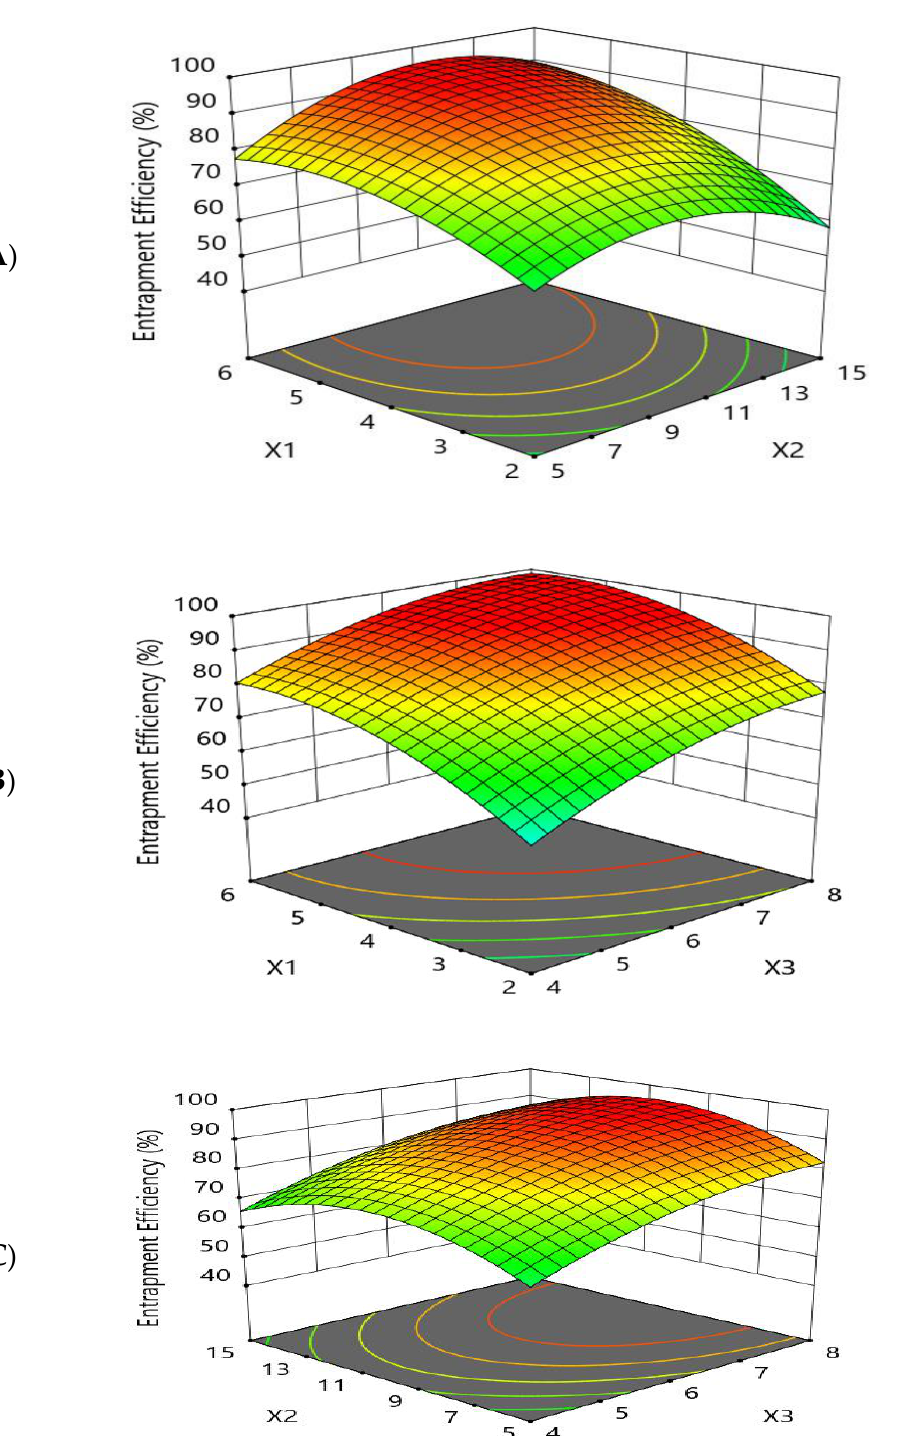
Figure 2. Response-surface-methodology plot for the effect of formulation factors (X1, X2, and X3) on the entrapment efficiency percentage (Y1). ( A ) Effect of sodium alginate concentration and cross-linker concentration on the entrapment efficiency percentage (Y1); ( B ) effect of sodium alginate concentration and sesame oil concentration on the entrapment efficiency percentage (Y1); and ( C ) effect of cross-linker concentration and sesame oil concentration on the entrapment efficiency percentage (Y1).